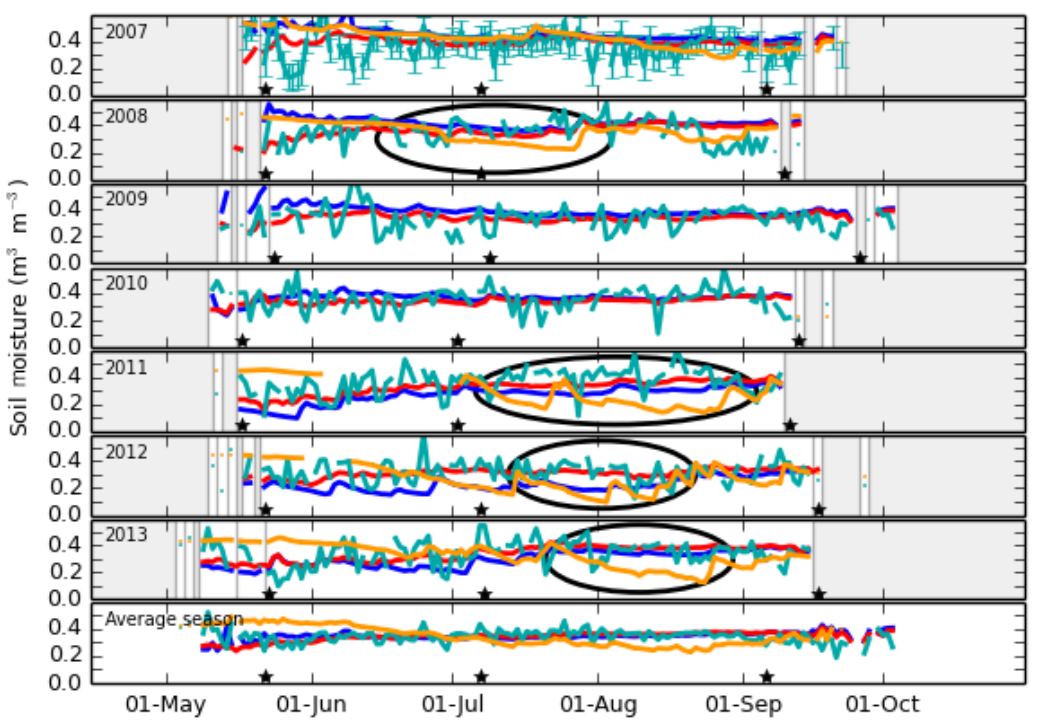
Figure 6. As Fig. 5, but for the Tver wet forest site.